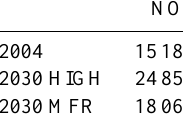
Table 1b. Non-Arctic ship emissions in 2004 and 2030 (Ktonyr − 1 ). The non-Arctic ship traffic distribution and emissions for 2004 are from Dalsøren et al. (2009). The 2030 emission scenarios are based on Corbett et al. (2010a). There is seasonal variation in the emis- sions. NO x SO 2 BC